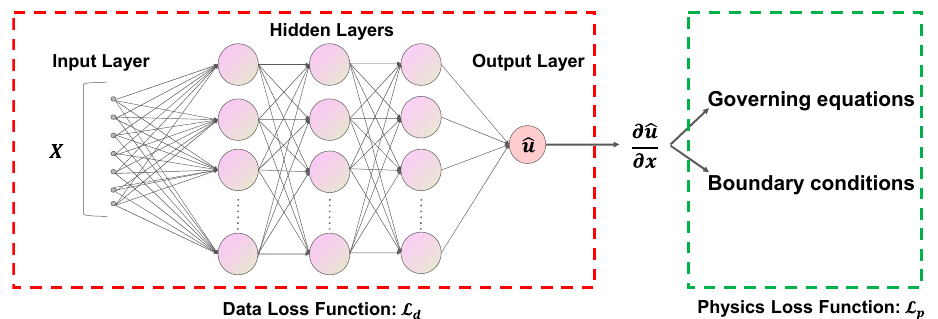
Figure 1. A physics-informed neural network containing two main components: an artificial neural network and a physics-informed loss function.